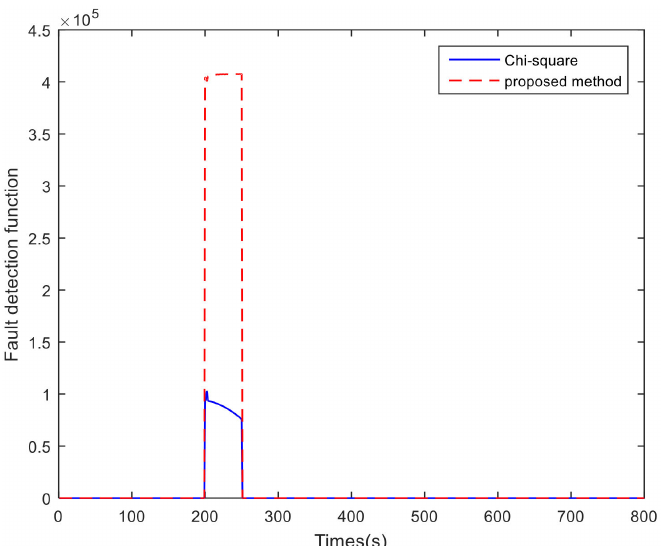
Figure 5. The test statistic of fault detection obtained by simulation under the single-satellite step fault.